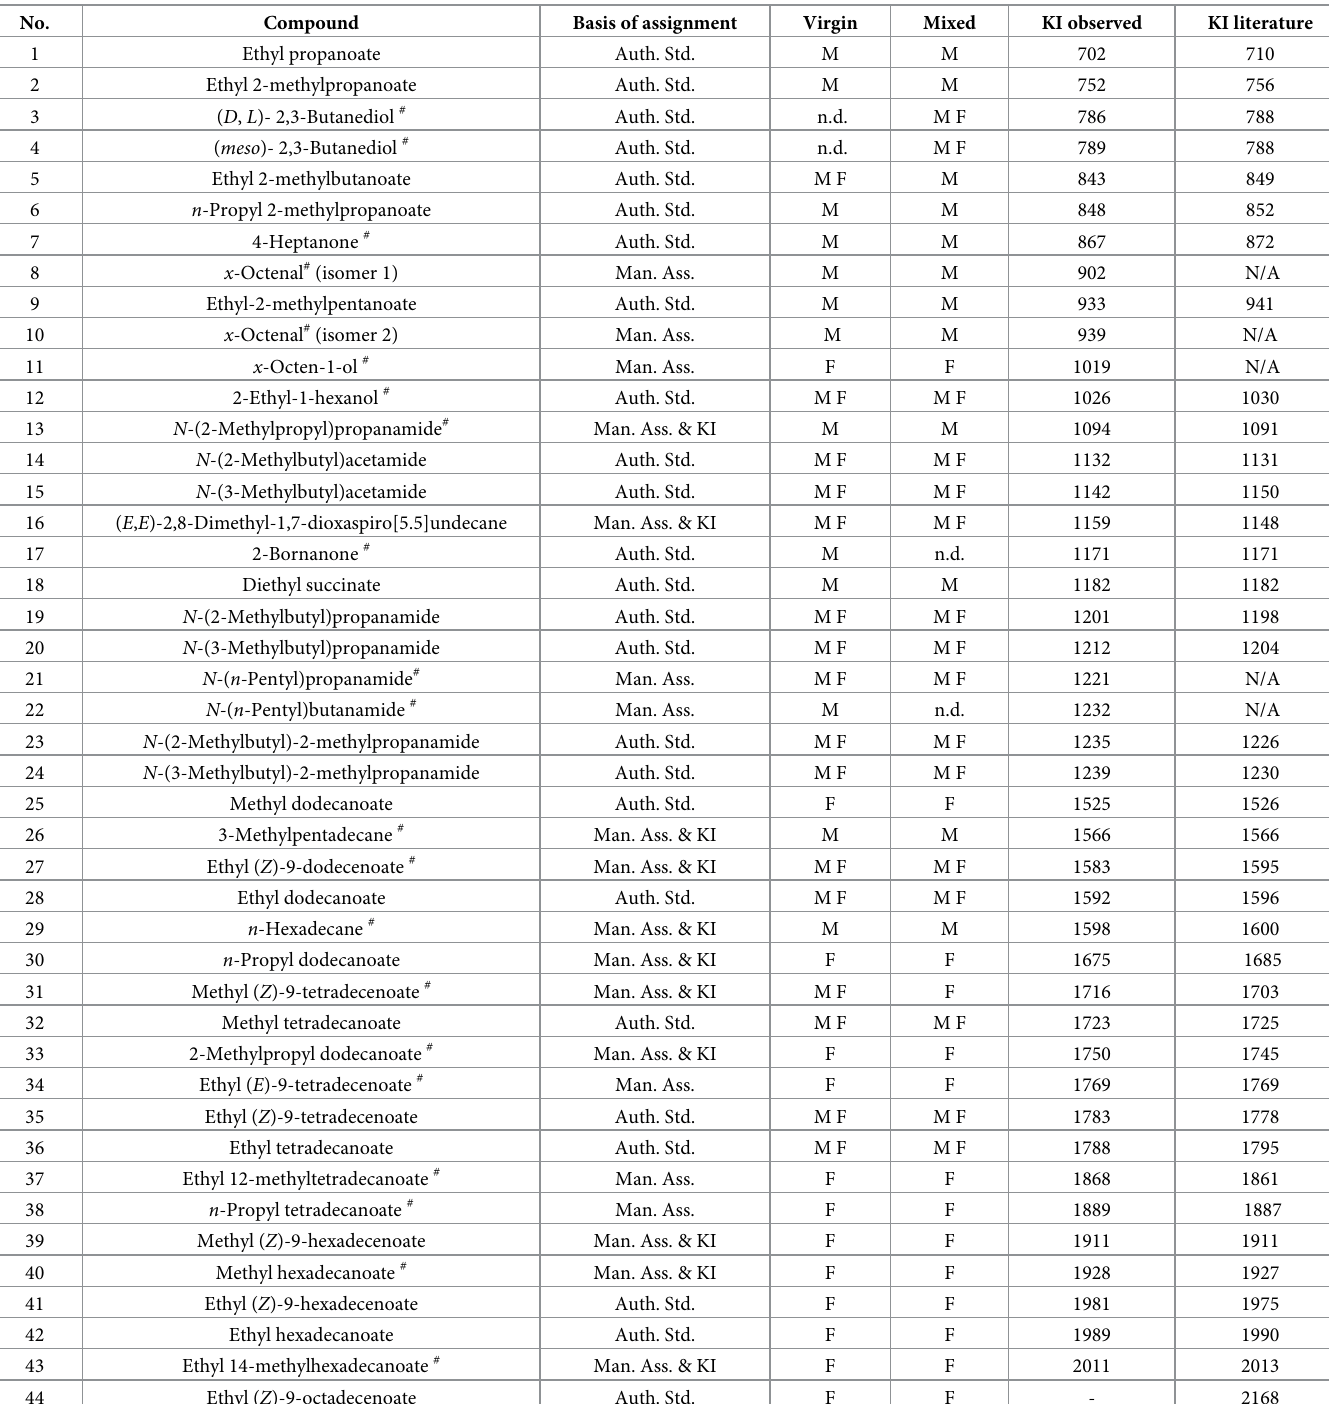
Table 1. Forty-five chemicals found in virgin and mixed sex groups of male (M) and female (F) rectal glands. No. Compound Basis of assignment Virgin Mixed KI observed KI literature Ethyl propanoate Auth. Std.